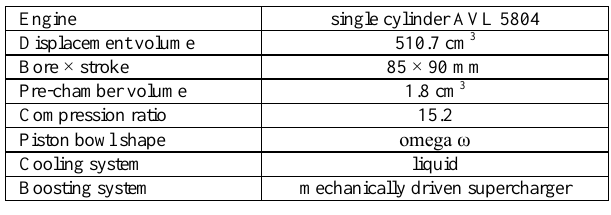
Table 1. Engine technical data